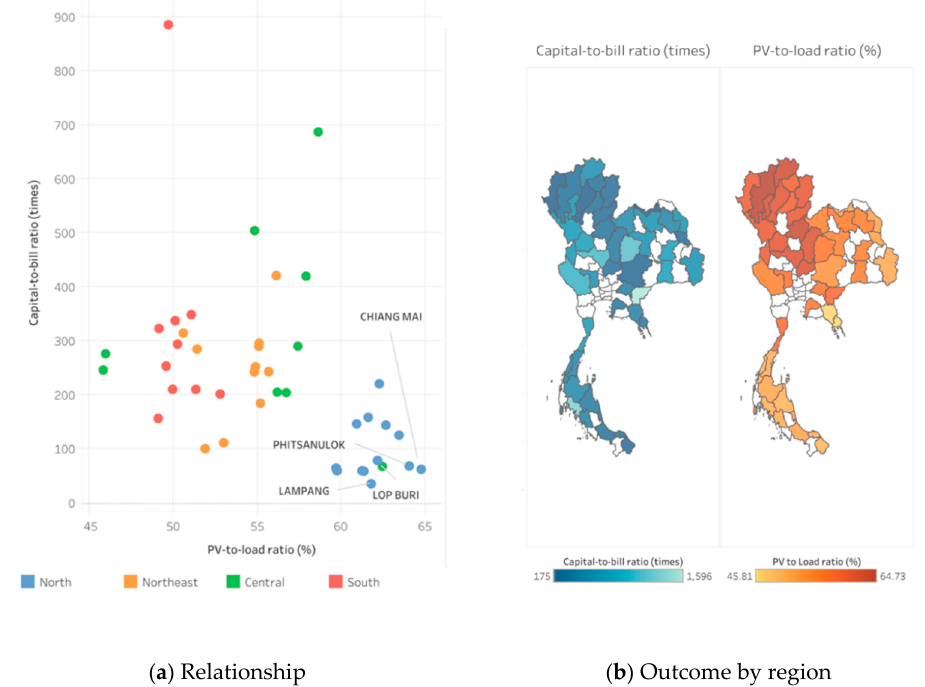
Figure 15. LGS customer investment hotspots (under a net-billing compensation scheme with a 1 THB/kWh buyback rate).